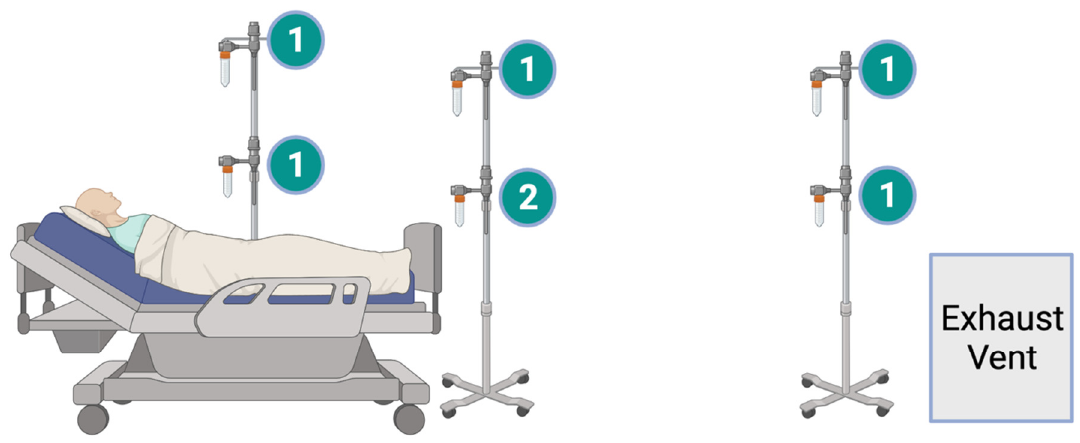
Figure A1. Locations of the aerosol samplers in patient